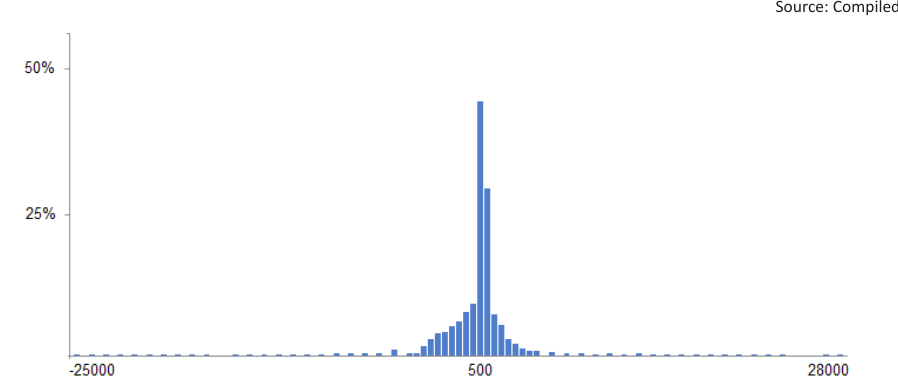
Figure 2. Monte Carlo simulation result of a short-term cryptocurrency investment strategy (the profit/loss per one